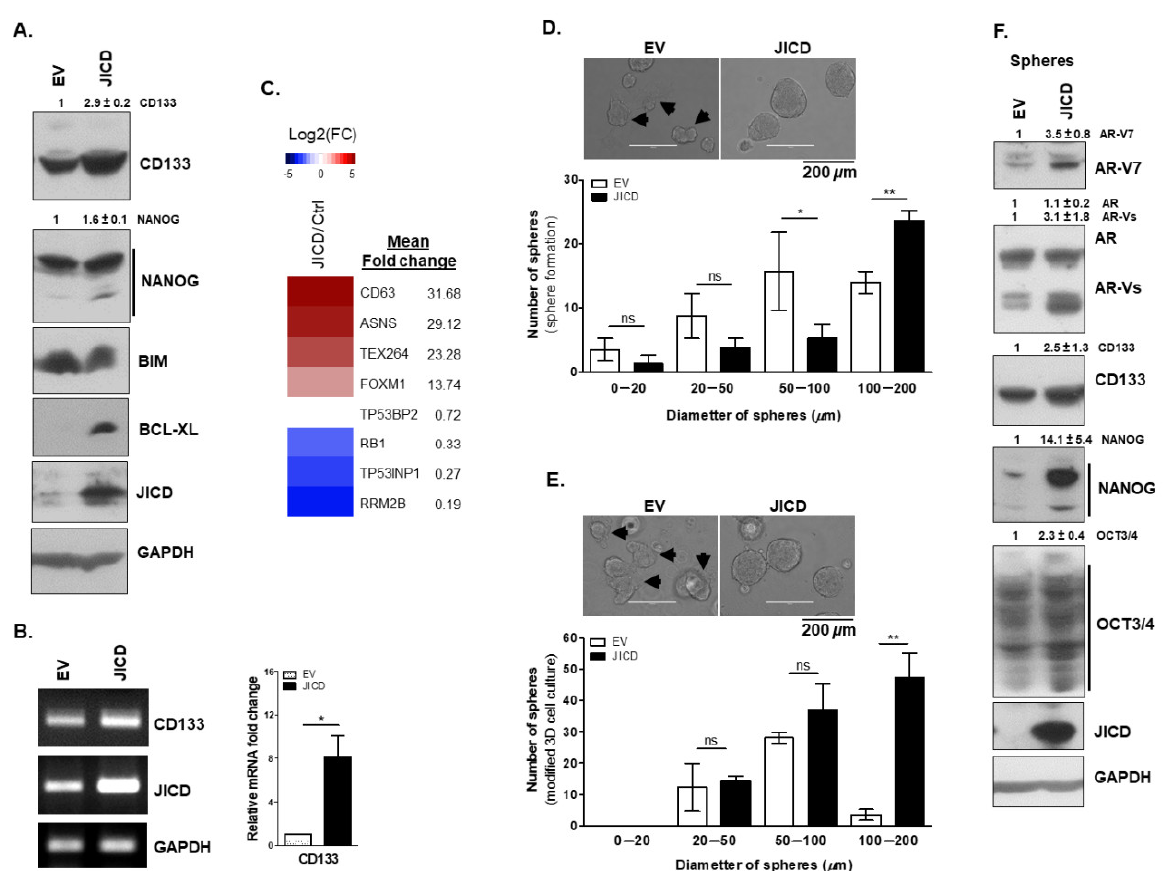
Figure 4. JICD promotes prostate cancer stem–like cell properties in prostate cancer cells . ( A , B ) Overexpression of JICD increases CSC marker expression in prostate cancer cells. Representative Western blot analysis ( A ) showing the protein levels of CD133, NANOG, BIM, BCL–XL, and JICD; Representative RT–PCR ( top ) and quantitative RT–PCR (qPCR; bottom ) analysis of three independ- ent experiments ( B ) revealing the mRNA levels of CD133 and JICD in stable EV– or JICD–overex- pressing CWR22Rv1 subline cells. GAPDH was used as a loading control. Data are shown as mean